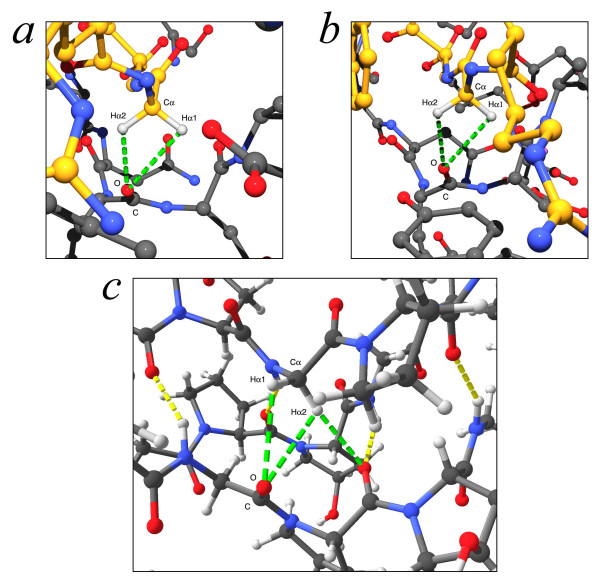
Geometry of Gly-Cα···O=C interactions after Gly α-hydrogen atoms are placed in their stereochemically predicted positions for: (a) the cRGD-αVβ3 crystal structure, and (b) the EFB-αIIbβ3 crystal structure. Atoms are colour coded as follows: oxygen, red; nitrogen, blue; hydrogen, white; metal, purple; carbon from integrin in grey; and carbon from the cRGD and EFB peptides in orange. Cα-H···O hydrogen bonds are shown as green dashed lines. (c) Hydrogen bonding in the collagen triple helix [15]. Conventional hydrogen bonds are shown in yellow, Cα-H···O hydrogen bonds in green. The two Hα atoms in collagen Gly residues participate in a bifurcated and three-centred hydrogen bonding configuration. Naming of Gly-Hα atoms follows the convention that Hα1 is equivalent to Hα in L-amino acids.